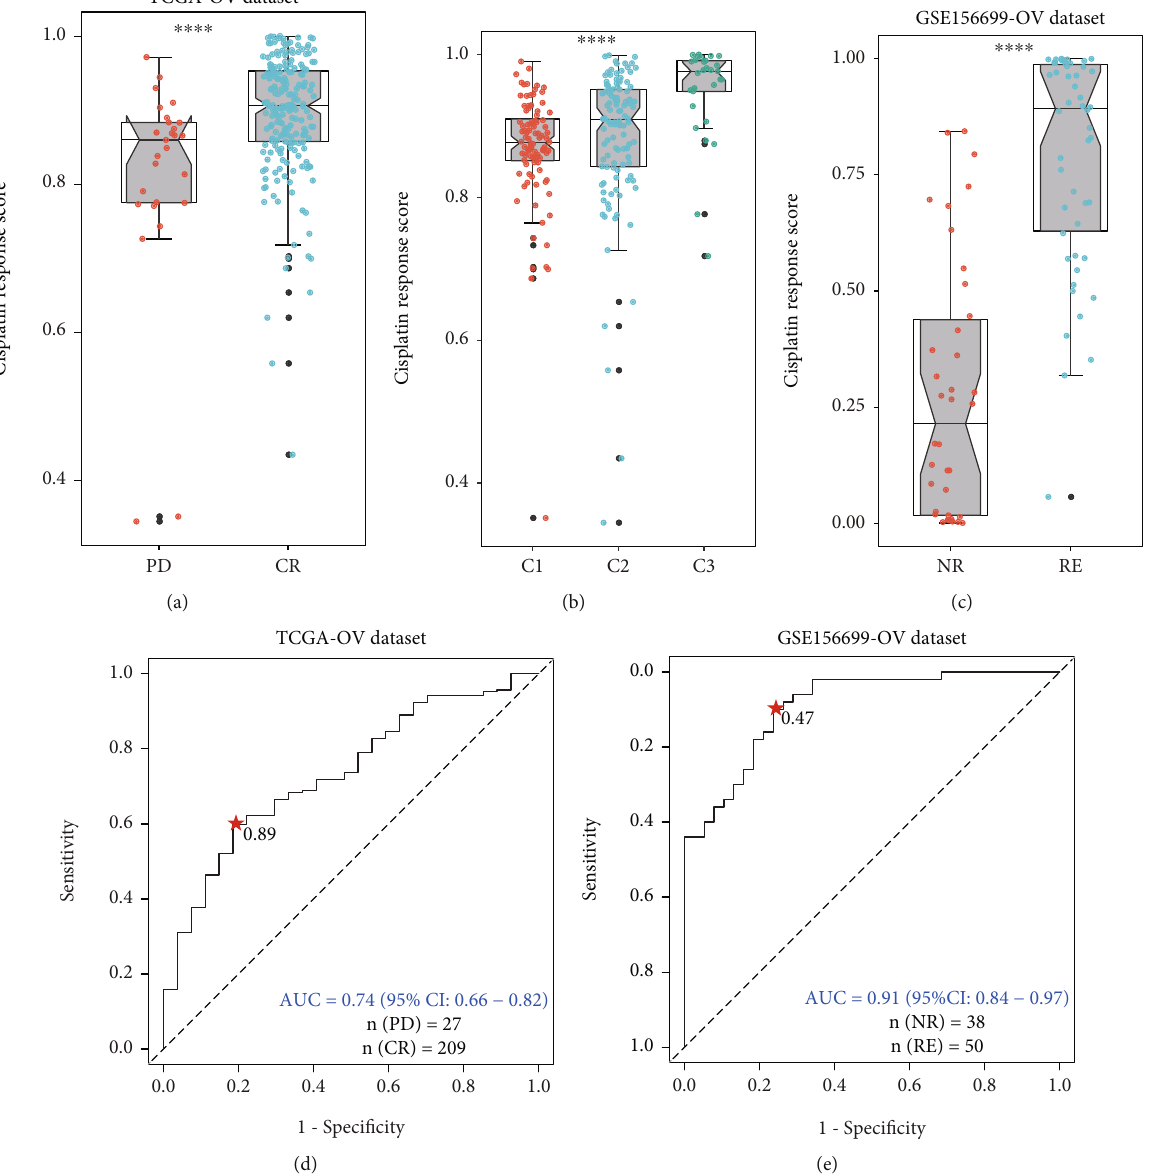
Figure 3: The performance of the cisplatin response model. (a) The cisplatin response scores of CR and PD samples in TCGA-OV dataset. PD: disease progressed; CR: complete response. (b) The cisplatin response scores of samples between the three groups. (c) The cisplatin response scores of RE and NR group samples in the GSE156699 dataset. NR: nonresponse; RE: response. (d) ROC curve showed the performance of the cisplatin response model in TCGA-OV dataset. (e) ROC curve showed the performance of the cisplatin response model in the GSE156699 dataset. The red stars indicated the best cut-o ff values when Youden ’ s index reached the maximum in (d) and